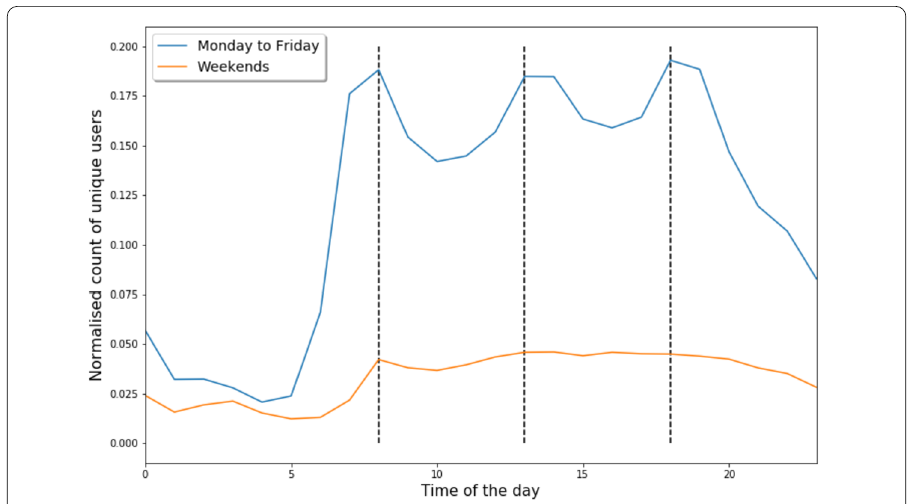
Figure 3 Comparison between connections on weekends and working days. Values are normalized over the population of the area from where the connection is made. The dashed lines correspond to commuting hours: it is evident how during the weekends the effect of the floatingpopulation are strongly